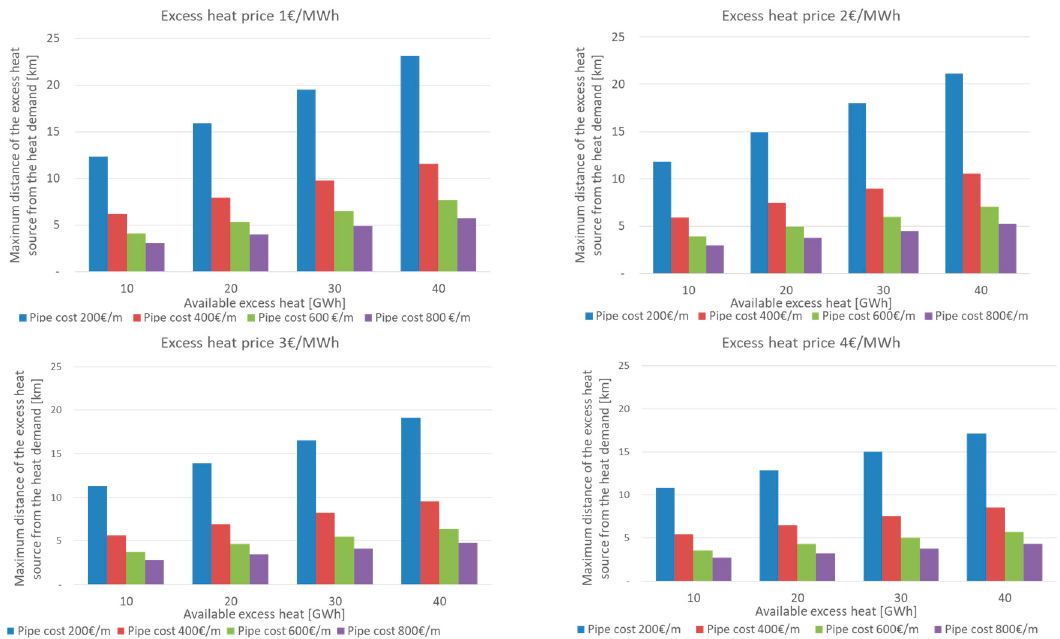
Figure 4. Maximum distance of the excess heat source from the heat demand for different values of available excess supply, excess heat price, and costs of pipes.